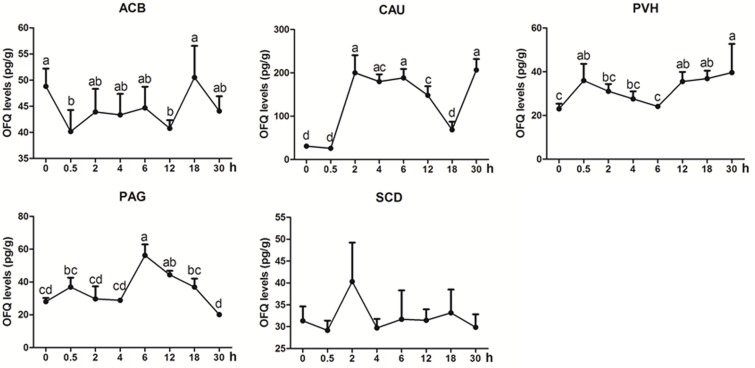
The effect of EA on OFQ levels in the CNS of goats (mean ± SD, n = 6). OFQ levels in the nucleus accumbens (ACB), the caudate nucleus (CAU), the paraventricular nucleus of the hypothalamus (PVH), the periaqueductal gray (PAG), and the spinal cord dorsal horn (SCD). The values with different letters differ significantly (p < 0.05). One-way ANOVA followed by Bonferroni’s post-test.